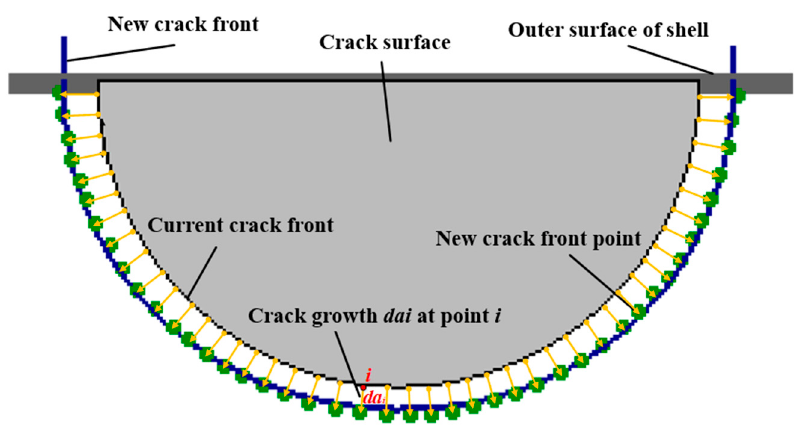
Figure 5. New crack front after fitting.